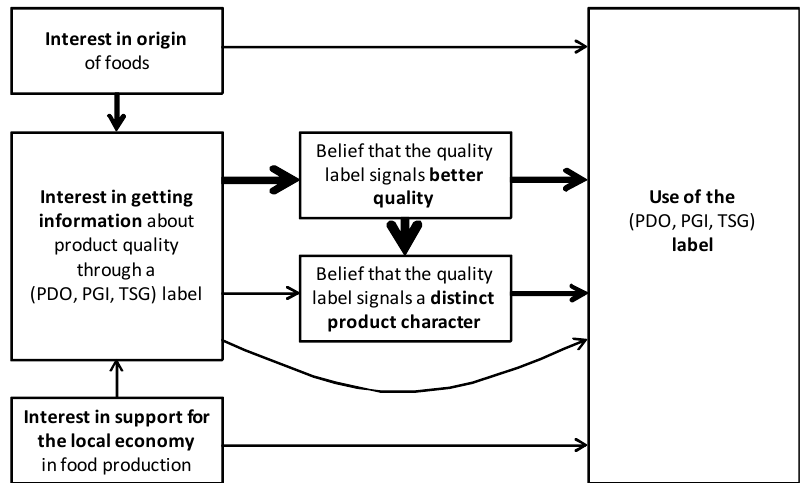
Figure 1. Conceptual framework: determinants of use of quality labels (PDO, PGI,